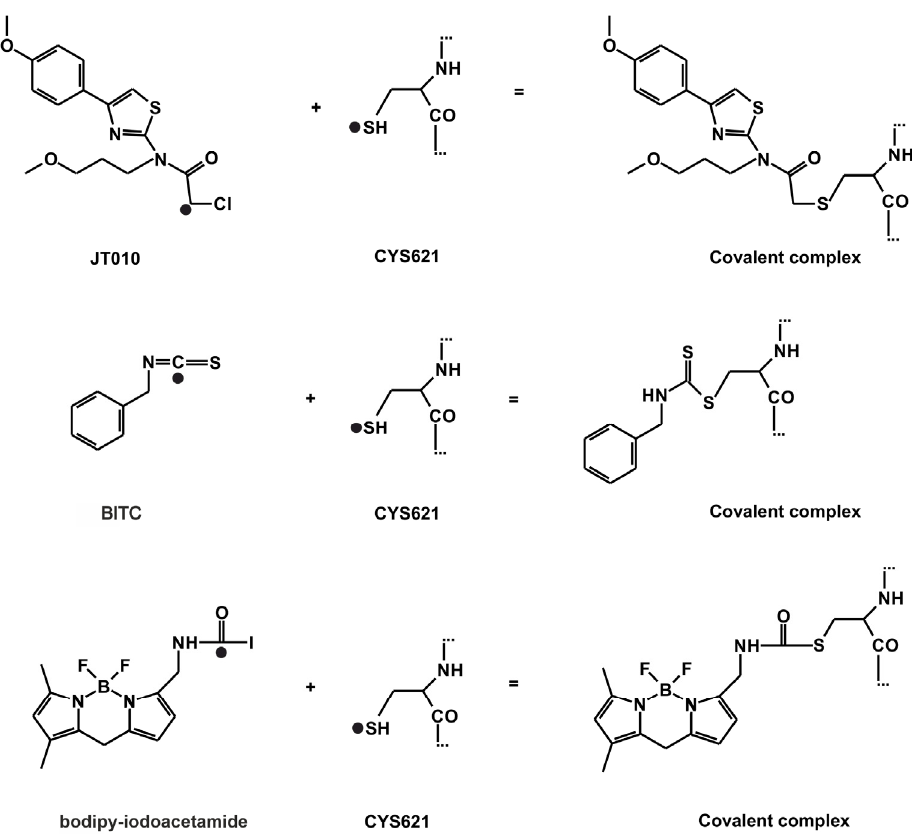
Figure 3. The reaction schemes of JT010, BITC, bodipy-iodoacetamide. Atoms, that participate in the formation of the covalent bond are highlighted by a black dot ( ● ). The distance of these two atoms is referred to as d. Table 1. Covalent docking calculations performed by FITTED [13–15].